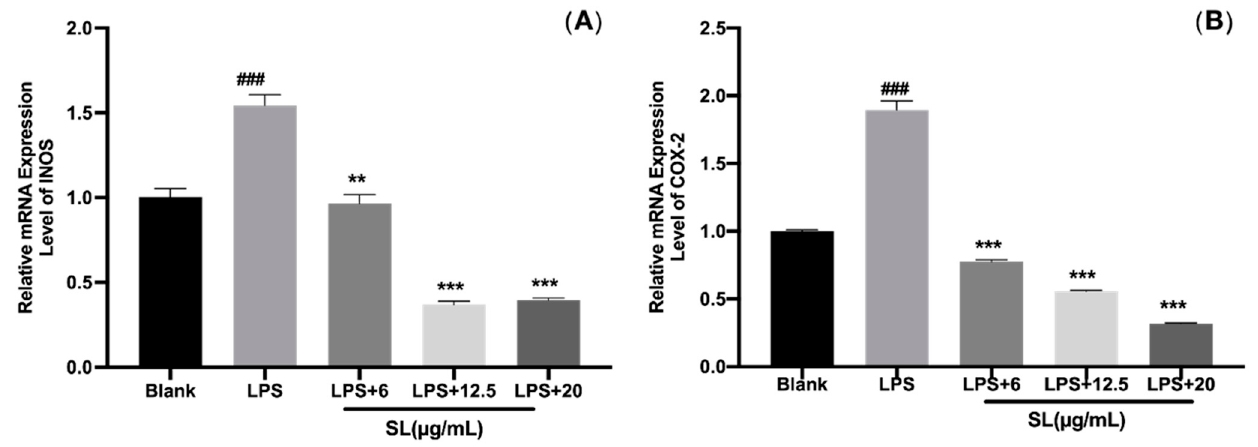
Figure 5. Effect of SLs on the LPS-induced expressions of iNOS and COX-2 in RAW264.7 cells. Cells were incubated with 1 μ g/mL of LPS with or without SL for 8 h. The mRNA expressions of ( A ) iNOS and ( B ) COX-2 were analyzed by RT-PCR. The results are presented as the mean ± standard error (n = 3), and a p -value less than 0.05 was expressed as statistically significant (###, p < 0.001 vs. blank group; **, ***, p < 0.01, 0.001 vs. LPS treatment group).